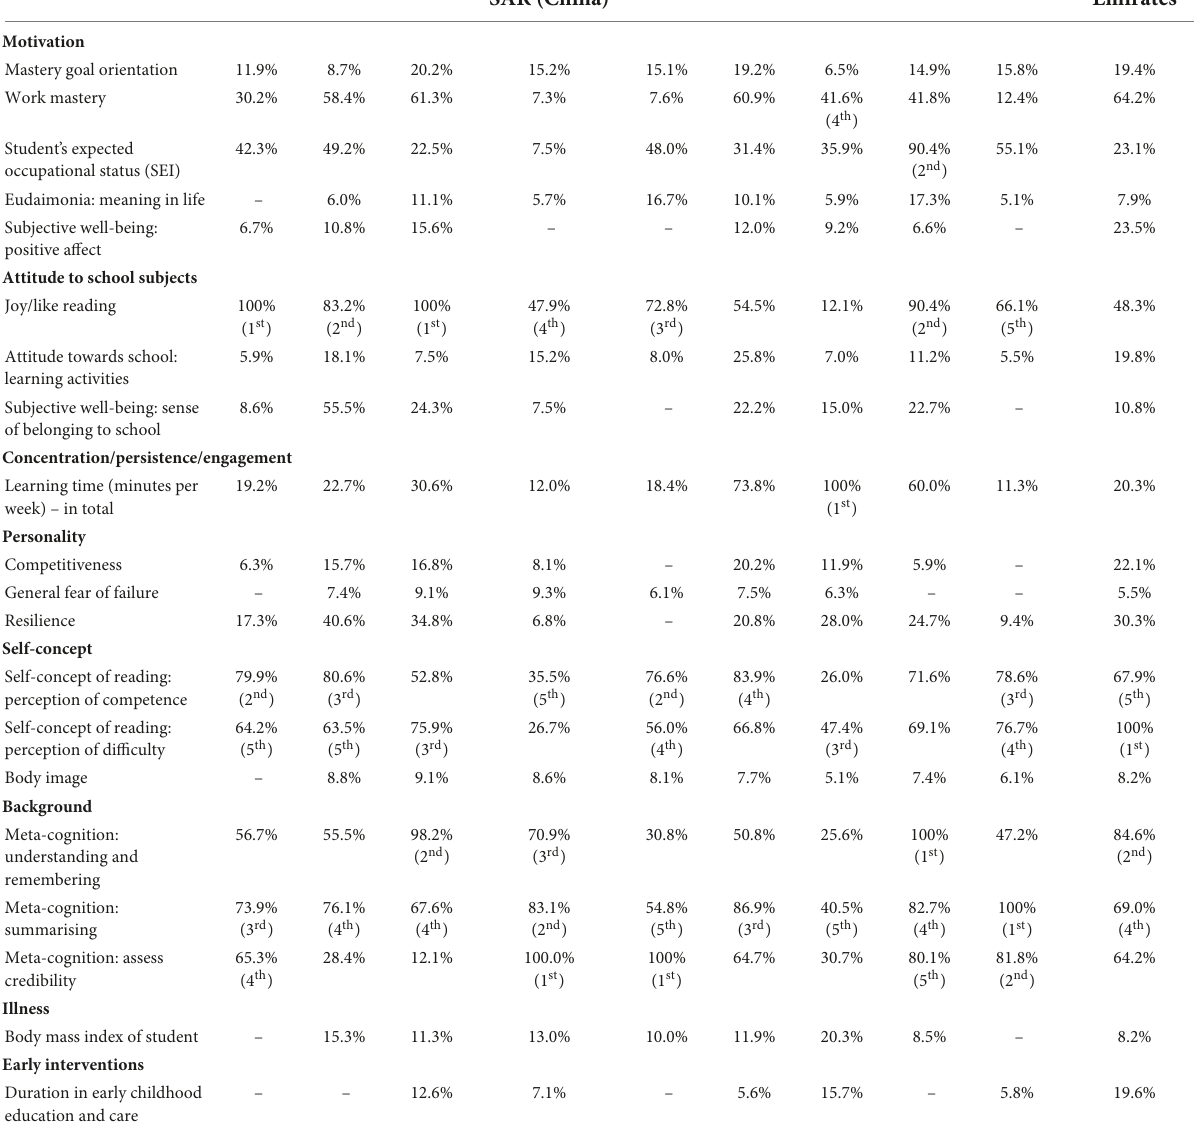
TABLE 6 Standardised importance of the independent student